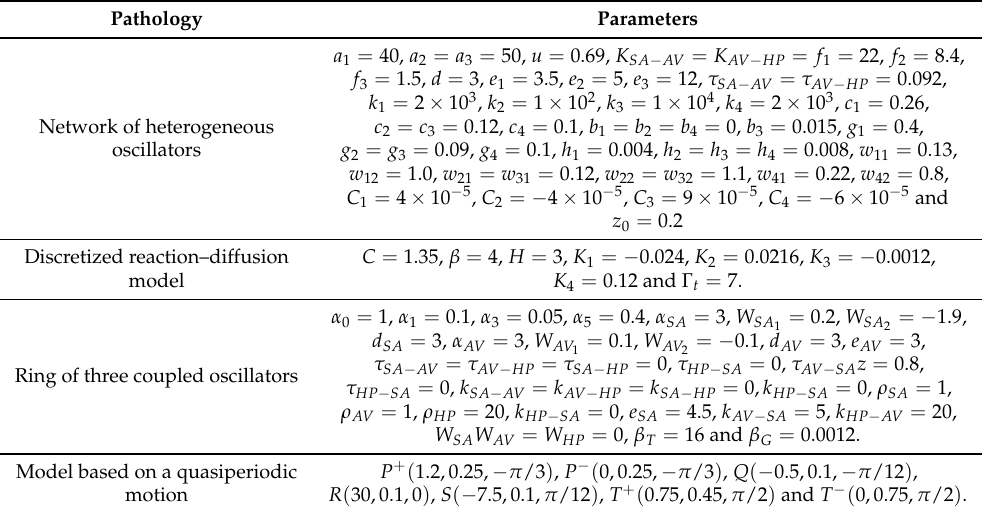
Table 1. Parameter values for reproducing normal rhythms using different models. In the model based on a quasiperiodic motion, the parameters of the Gaussian kernels are expressed by the values of ( a i , b i , θ i ) for each characteristic